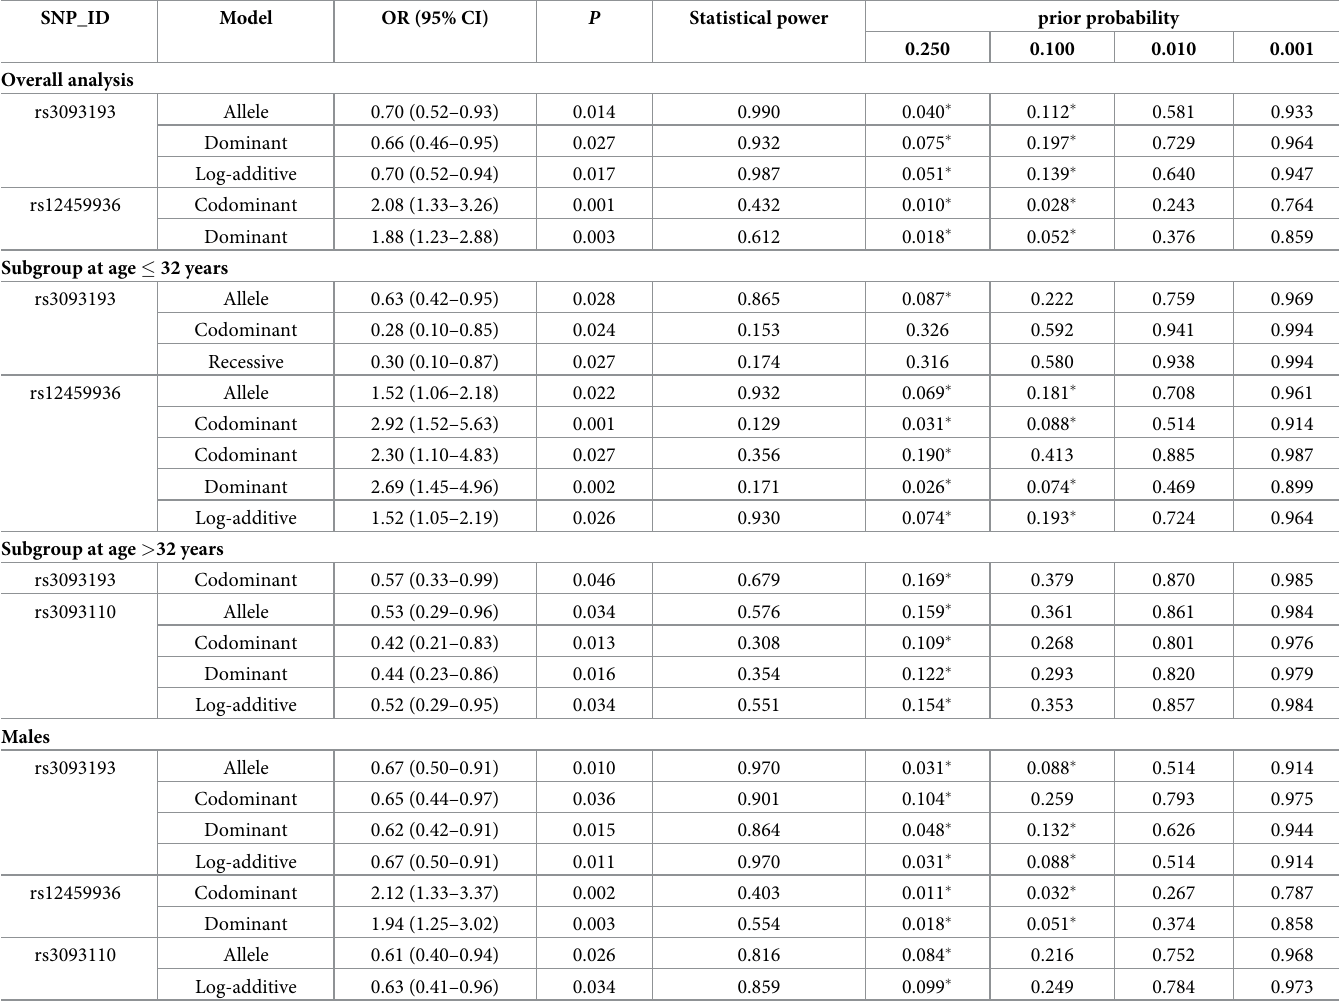
Table 9. False-positive report probability values for the association of CYP4F2 with HAPE risk.